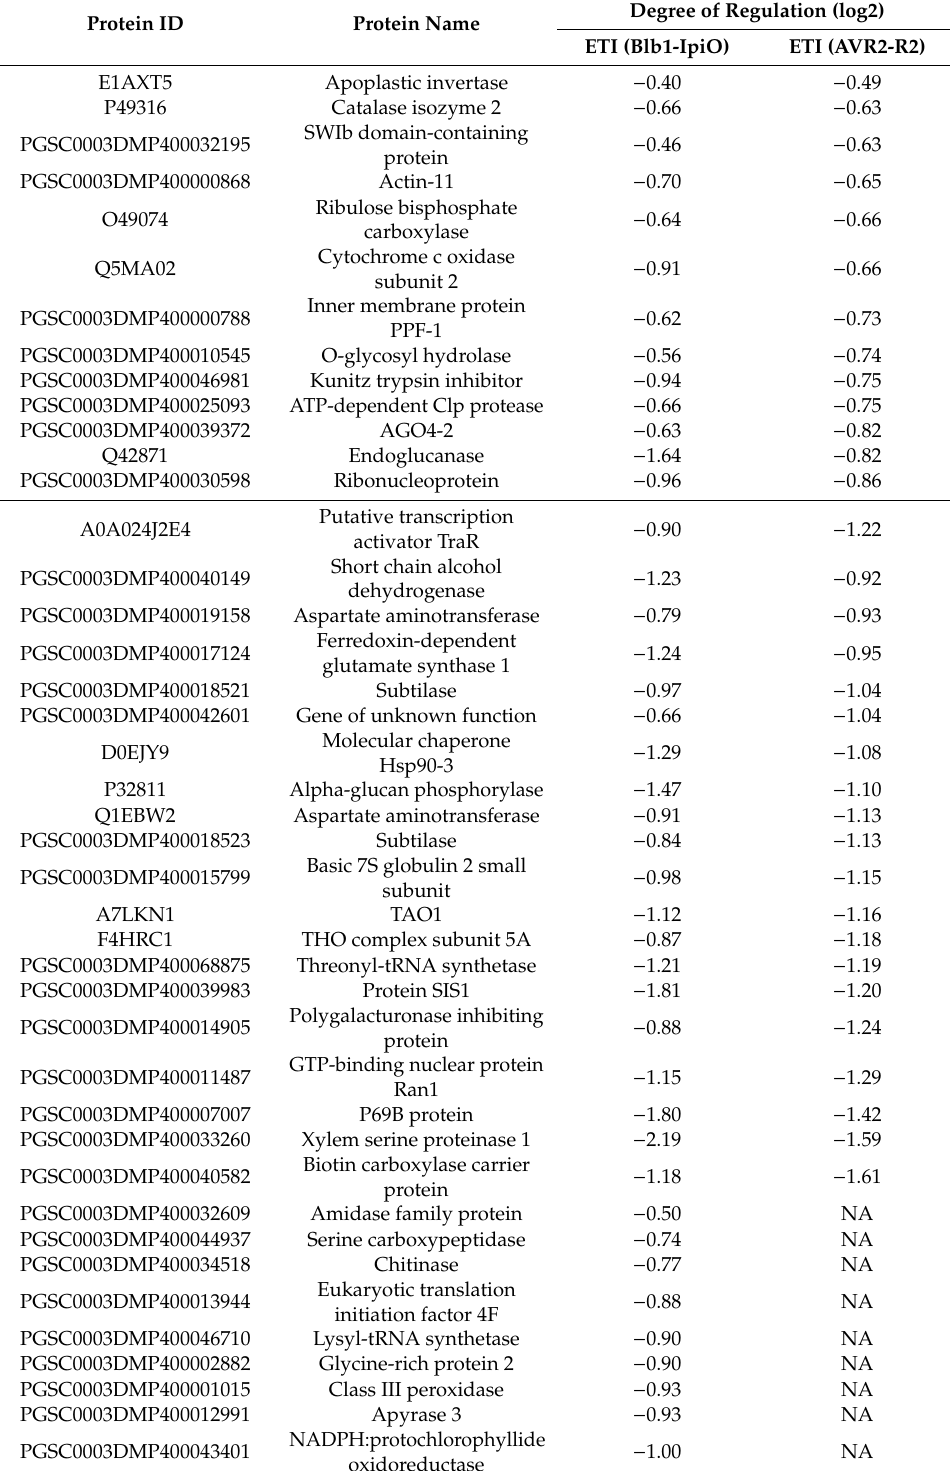
Table 4. Proteins from two ETI interactions with decreased abundance (ETI-IpiO and ETI-Avr2), 18 hpi (hours post infiltration). A comparison is made between immune-treated plants and the control plants infiltrated with medium only. All values are in log2 fold. Non-significant p values are indicated by NA. All p -values < 0.01 are shown in the